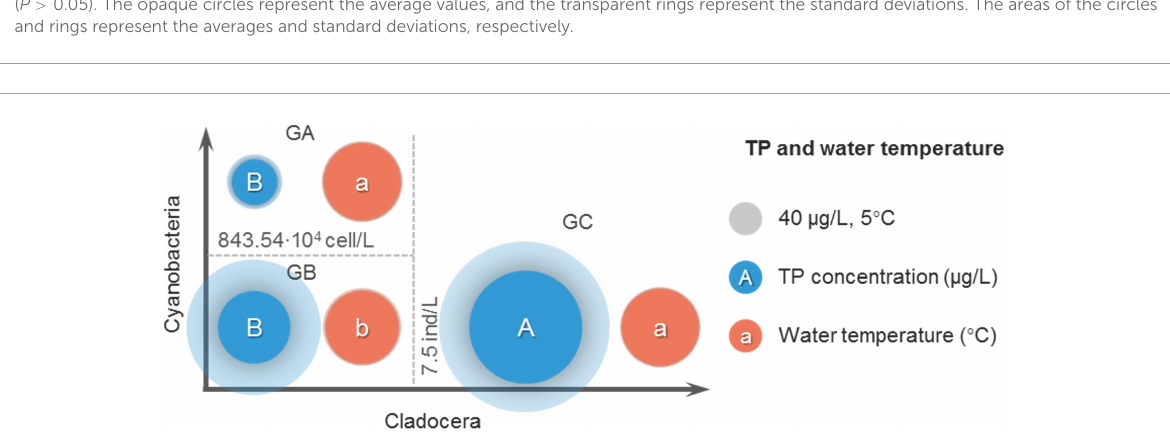
In fact, similar non-linear changes may exist in many forms in aquatic ecosystems. Through the quantitative study of these non-linear changes, it may be easier to reveal the mechanism of complex change in the whole